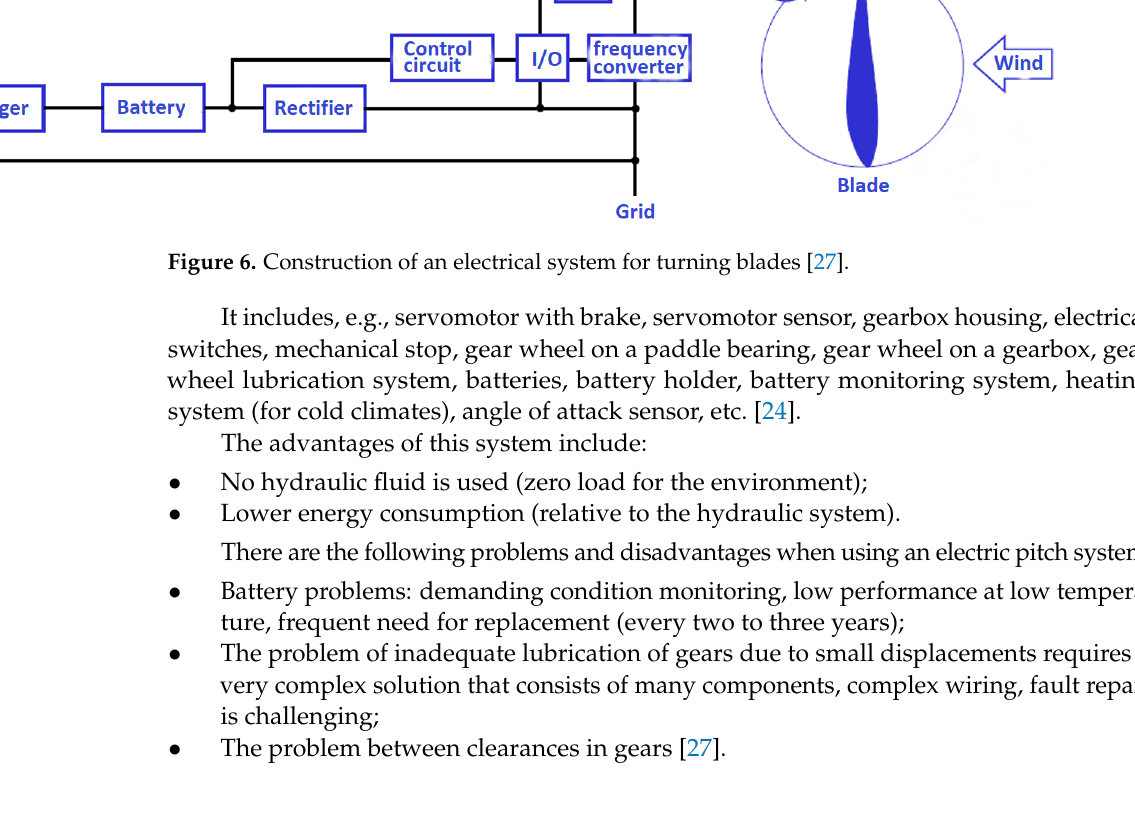
Figure 5. Construction of an electrical system for turning blades [27].